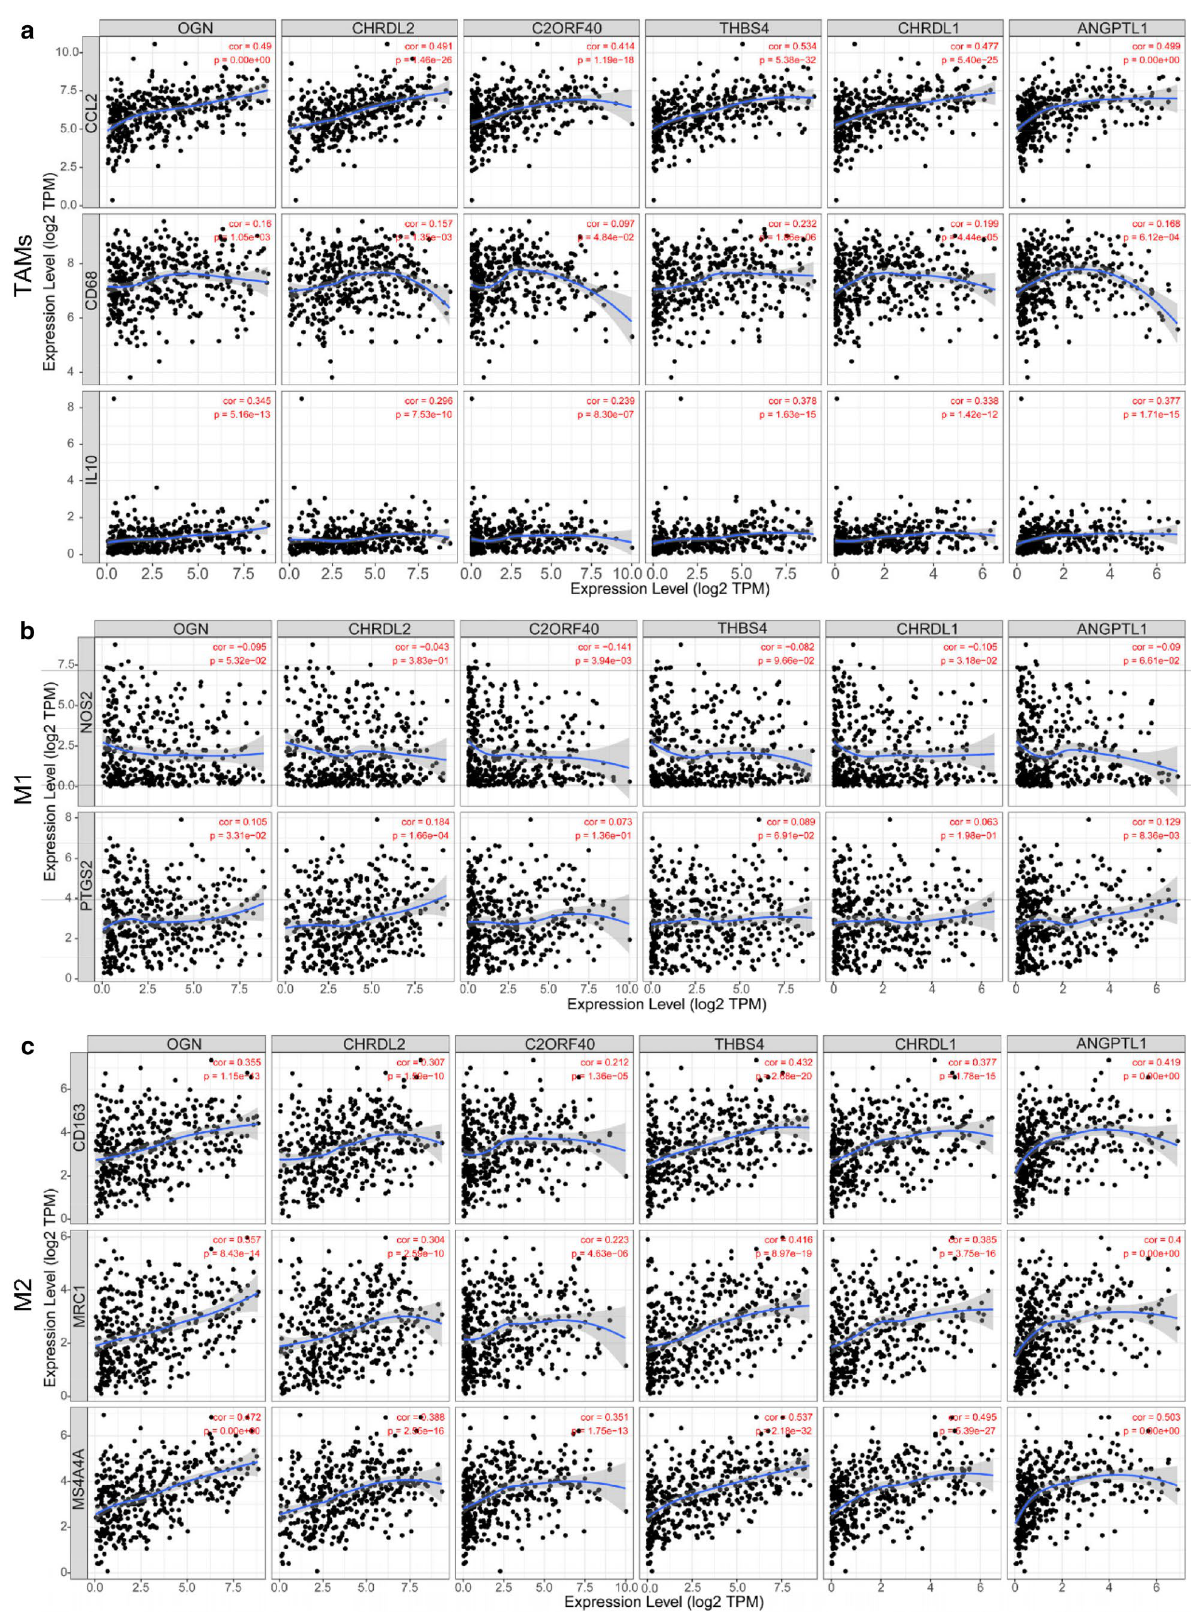
Fig. 4 Expression of six hub genes correlated with TAM polarization in the TME of GC. Scatterplots outline the relationship between the expression of six hub genes and various gene markers of TAMs ( a ), M1 macrophages ( b ), and M2 macrophages ( c ) by